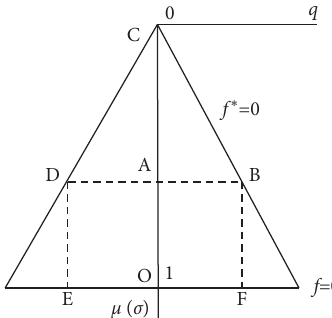
Figure 2: Evolution path of plastic membership